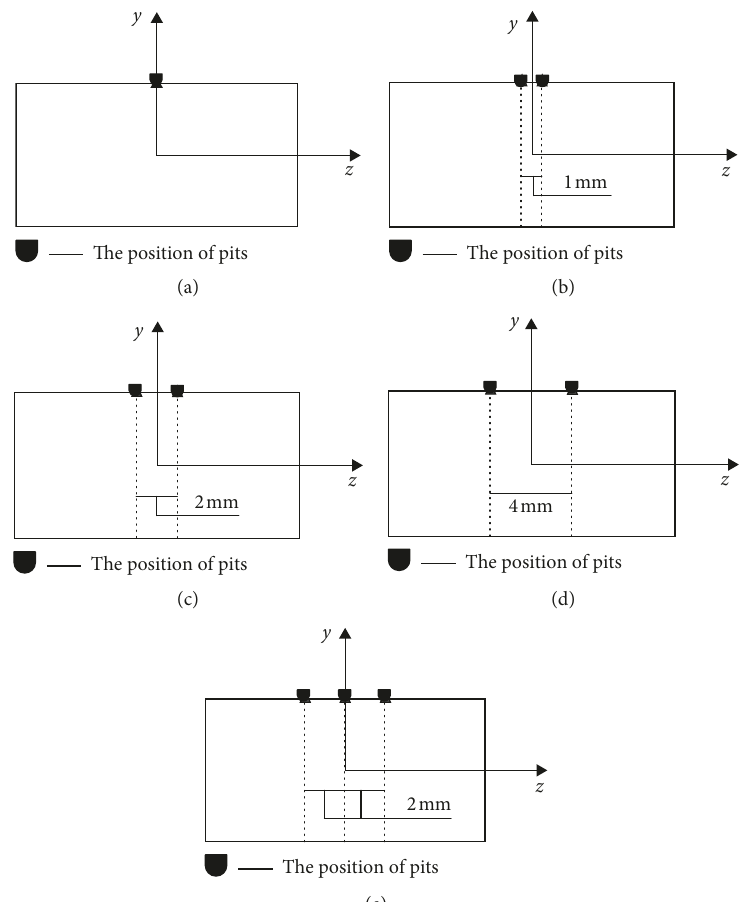
Figure 24: Schematic diagram of the cross section of steel wires with the different stepped multifatigue sources: (a) Case A; (b) Case B; (c) Case C; (d) Case D; (e) Case